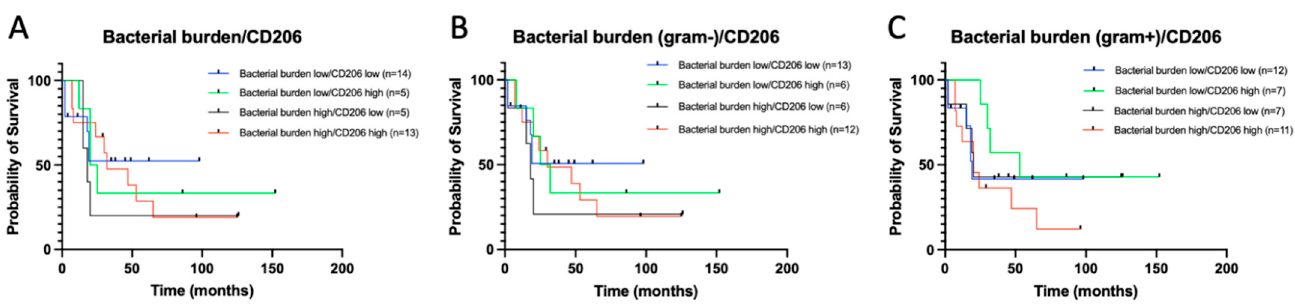
Figure 6. Survival of ESCC patients versus bacterial burden ( A ), Gram-negative bacterial burden ( B ) and Gram-positive bacterial burden ( C ) and CD206 + macrophages. No statistically significant differences were found for the groups shown on panels A and B. On the panel C the only statistically significant difference is between Bacterial burden high/CD206high and Bacterial burden low/CD206high groups (HR = 2.651, p = 0.044).